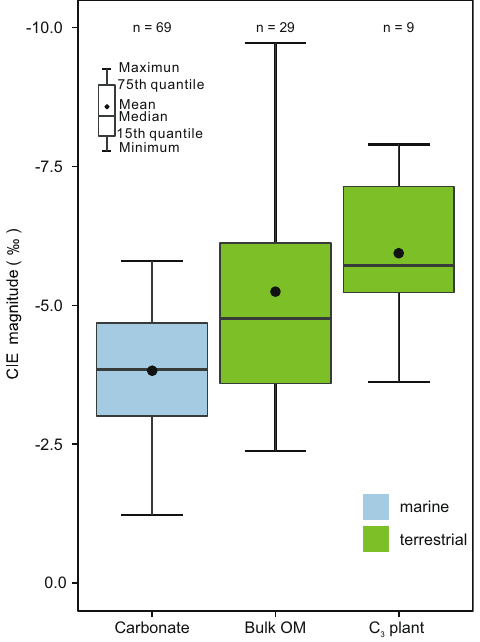
Fig. 2 Boxplot of carbon isotope excursion magnitudes for three substrates. Carbon isotope excursion (CIE) magnitudes of marine carbonate, terrestrial bulk organic matter (OM), and terrestrial C 3 plant compiled from the literature and this study. The magnitude of the terrestrial CIE is larger compared to the marine CIE magnitude. The Wilcoxon test suggests that the CIE magnitude between marine and terrestrial substrate is statistically different (Supplementary Table 1, p < 0.001). A Kruskal- Wallis test further shows the signi fi cant difference of CIE among marine carbonate, terrestrial bulk organic matter and C 3 plant groups ( p < 0.001). The “ n ” value represents the number of δ 13 C pro fi